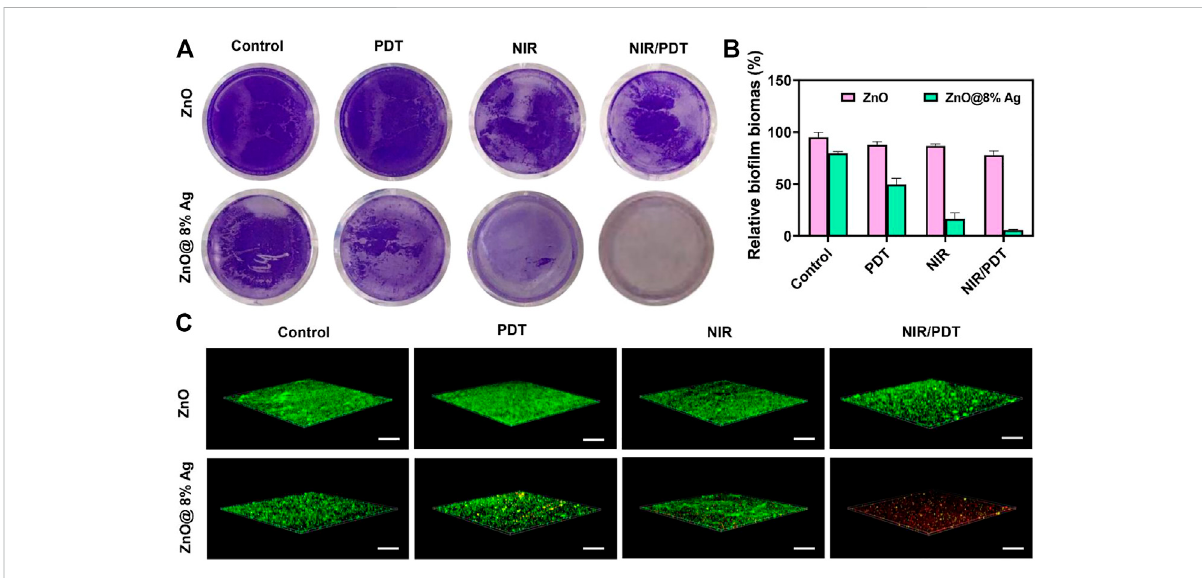
FIGURE 5 Inhibition of S. aureus bio fi lm. (A) Representative images of bio fi lm treated with ZnO, ZnO@8%Ag, ZnO + PDT, ZnO@8%Ag + PDT, ZnO + PTT, ZnO@8%Ag + PTT, ZnO + PTT + PDT, and ZnO@8%Ag + PTT + PDT, (B) quantitative analysis corresponding to (A) ** p < 0.01, and (C) live/dead staining assay of S. aureus in bio fi lms corresponding to (A) .